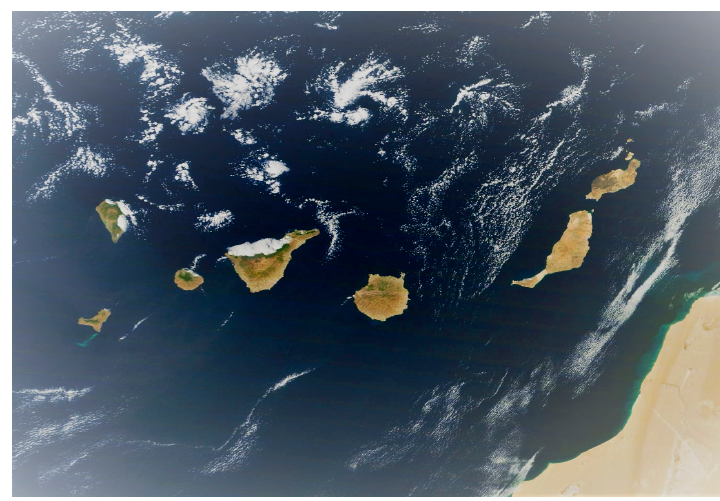
Figure 1. Canary Islands, National Aeronautics and Space Administration (NASA) image acquired 13 October 2011.